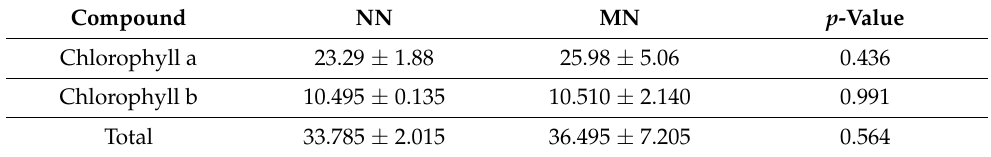
Table 3. Chlorophyll a and chlorophyll b of the culture in the aquaponic system over eight weeks. Compound Chlorophyll